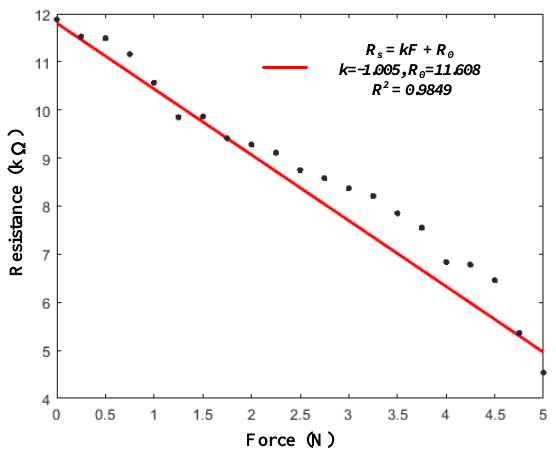
Figure 12. The fitting analysis of the benchmark sensing unit and the remaining 15 sensing